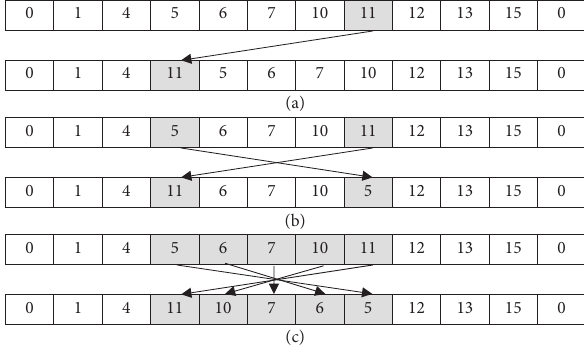
Figure 8: Neighborhood structures. The grey stations change their